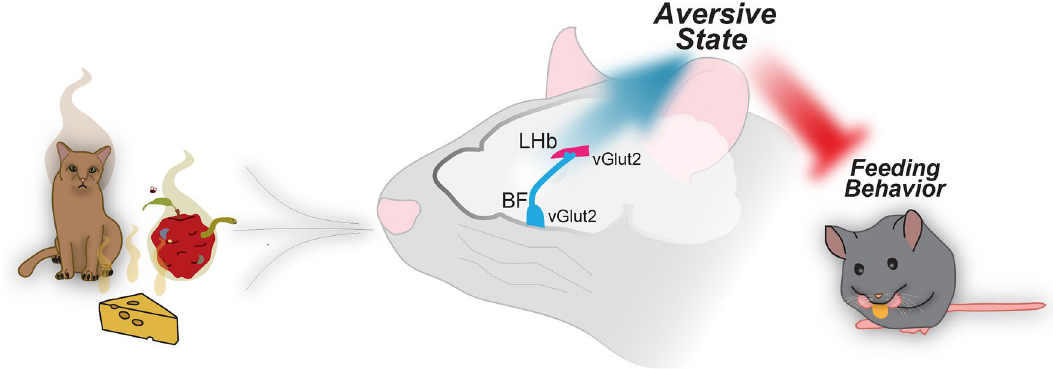
Figure 7. Graphical abstract. Olfactory sensory information is relayed to the LHb via BF glutamatergic circuitry to drive aversive behaviors, overriding appetitive behaviors such as